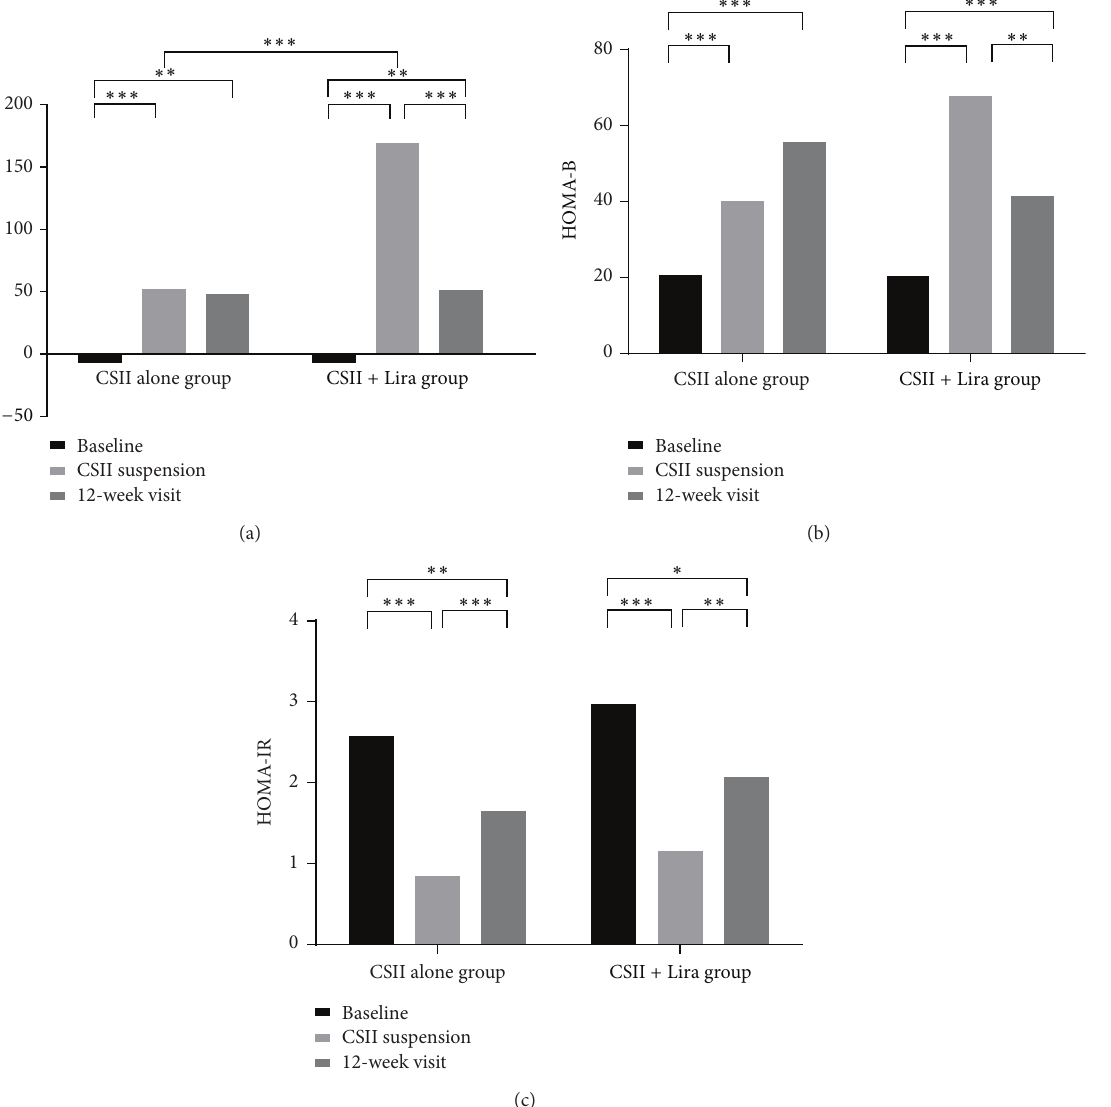
Figure 2: Beta cell function and insulin sensitivity of two groups, (a) AIR of baseline and after intervention, (b) HOMA-B of baseline and after intervention, and (c) HOMA-IR of baseline and after intervention, ∗ 𝑃 < 0.05 , ∗∗ 𝑃 < 0.01 , and ∗∗∗ 𝑃 < 0.001 .